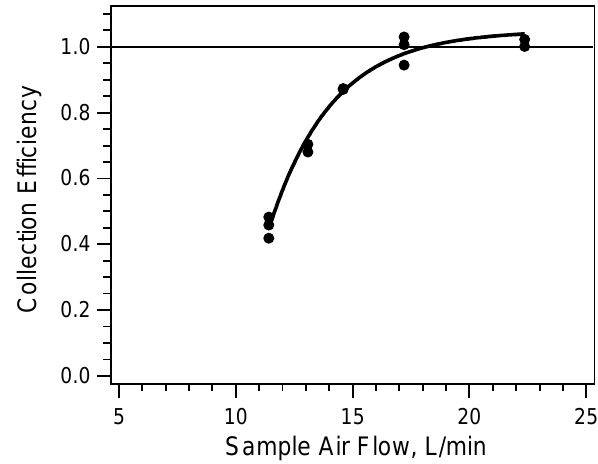
Fig. 5. Mist chamber collection efficiency. Collection efficiency determined by ratio of ambient sulfate measured with the mist chamber-IC to that from a PILS-IC